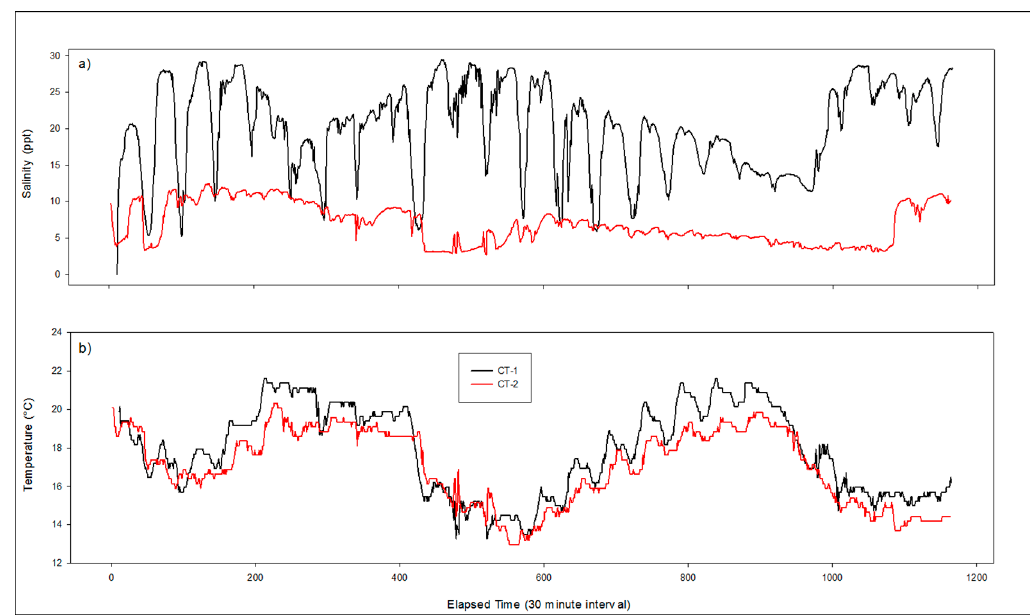
Figure 8. Salinity ( a ) and temperature ( b ) measurements taken with the moored application design from sites CT-1 and CT-2 during 13 November to 7 December 2015 deployment.